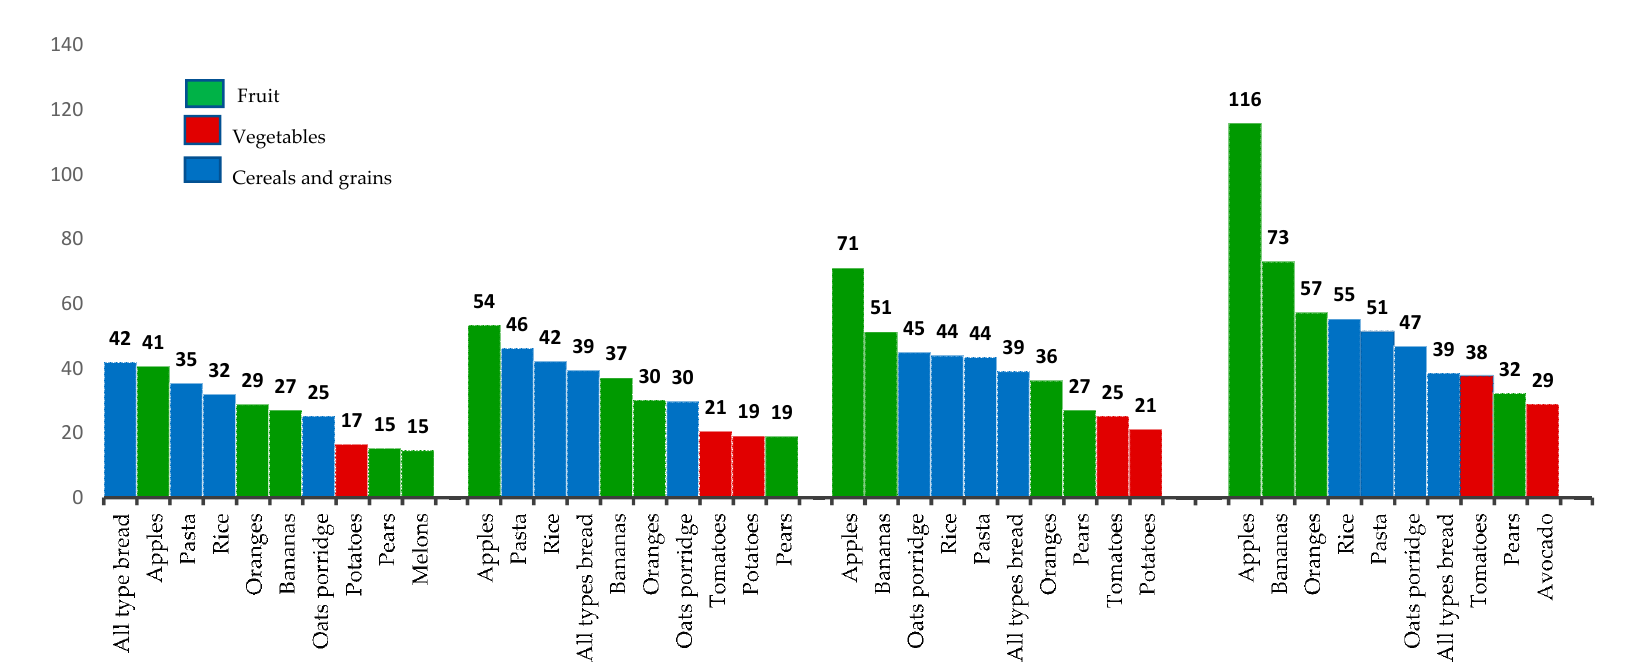
Figure 3. Ten most consumed fiber-rich foods by the women based on quartile fiber intakes.